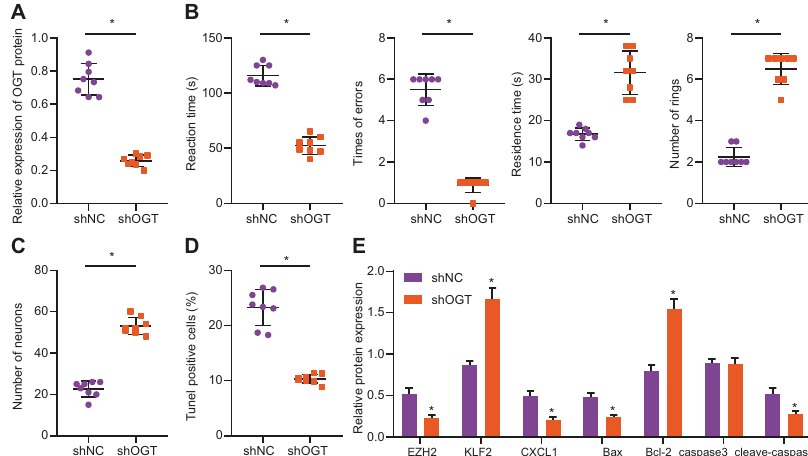
Fig. 6 Silencing OGT in vivo attenuates hypercalcemia-induced nerve injury in CKD mice. A Western blot analysis was used to detect the expression of OGT in the brain tissue of each group. B Escape latency and step-down tests were used to observe the changes of nerve function in CKD mice. C Immuno fl uorescence was used to detect the number of neurons in brain tissues of each group. D TUNEL staining was used to detect neuronal apoptosis. E Western blot analysis was used to detect the expression of EZH2, KLF2, CXCL1, and apoptosis-related proteins. * p < 0.05. vs. the sh-NC group (mice harboring neurons treated with sh-NC). n = 8 mice. The experiment was repeated 3 times